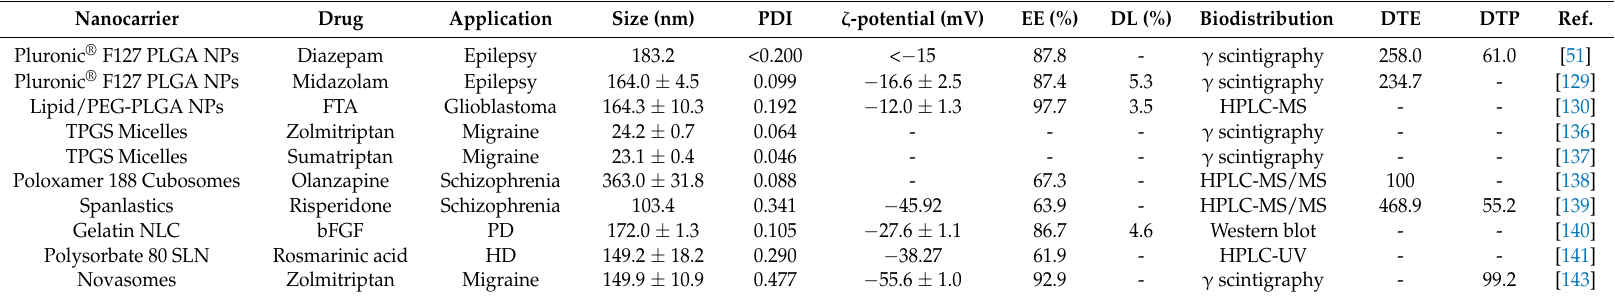
Table 2. Mucus-penetrating and penetration-enhancing nanocarriers studied for nose-to-brain